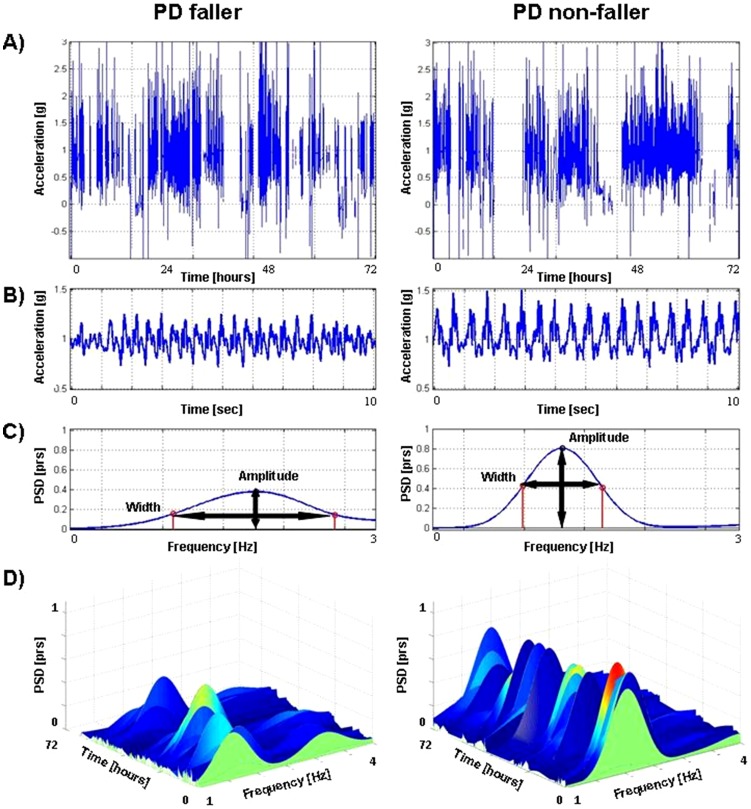
Examples of vertical acceleration signals of a PD faller (left) and a non-faller (right).
Figure 1A shows a 3-day raw acceleration signal. Figure 1B and 1C show the time and frequency domains of a 30 second signal (derived from the raw signal), respectively. The acceleration pattern of the PD faller (male, 61 yrs old) is less smooth compared to the PD non-faller (male, 74 yrs old) (Figure 1B). The peak amplitude of the dominant frequency is lower and wider in the faller compared to the non-faller, indicating of a less consistent, more variable gait pattern (figure 1C). Figure 1D shows an example of 3-day vertical acceleration signal in the frequency domains. The PD faller has a less consistent gait pattern, as reflected by the lower amplitude and wider spectrum. Similar findings are observed on a group level (recall Table 3).